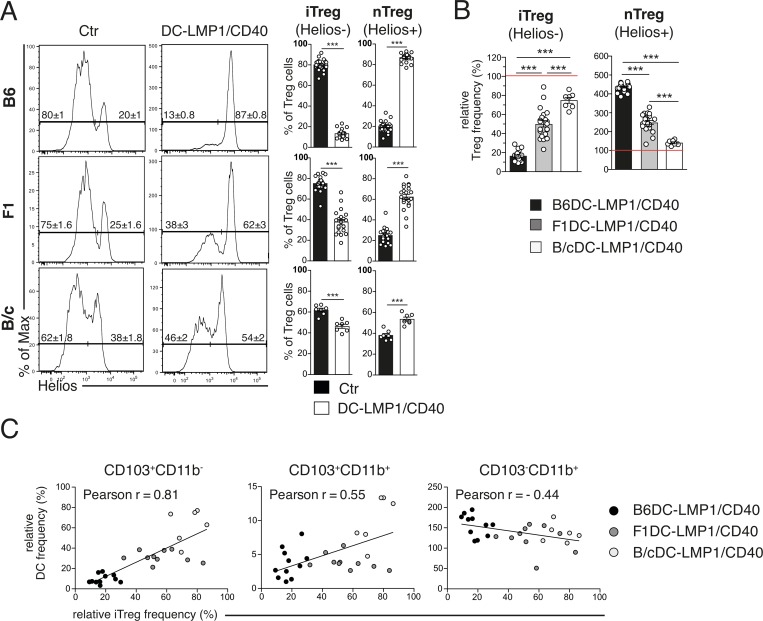
Graded impairment of iTreg induction is background dependent.Single cell suspensions of LP were analyzed for Treg cells. (A) Shown are representative FACS-plots of FoxP3+ Tregs found in the LP pre-gated on single, live, CD45+CD3+CD4+CD25+FoxP3+Helios+ nTregs or Helios- iTregs (S1B Fig). Numbers on FACS-plots and bar graphs indicate the frequency of Treg cell subsets, for each genetic background analyzed. Shown are pooled statistics from 7 (B6, n = 23–26), 6 (F1, n = 21) and 2 (B/c, n = 7) experiments with similar outcome. (B) The iTreg and nTreg frequencies from (A) are shown as relative data with the corresponding background control set as 100% (indicated as red line). (C) Relative DC subset (Fig 2B) and iTreg (Fig 3B) frequencies from each mouse were plotted against each other. Each symbol on the scatter plot represents one mouse. A line for linear fit was added on each scatter plot to visualize the relationship between DCs and iTregs. The strength of co-occurrence between DC subpopulations and iTregs is represented by Pearson Correlation coefficient (r), whose values range between -1 and +1. Data for LP were acquired and pooled from 3 (B6, n = 10–12), 4 (F1, n = 13–14) and 2 (B/c, n = 6–7) experiments with similar outcome. All bar graphs represent mean ± SEM and significance were analyzed using a student´s t-test, with *: P < 0.05, **: P < 0.01 and ***: P < 0.001.